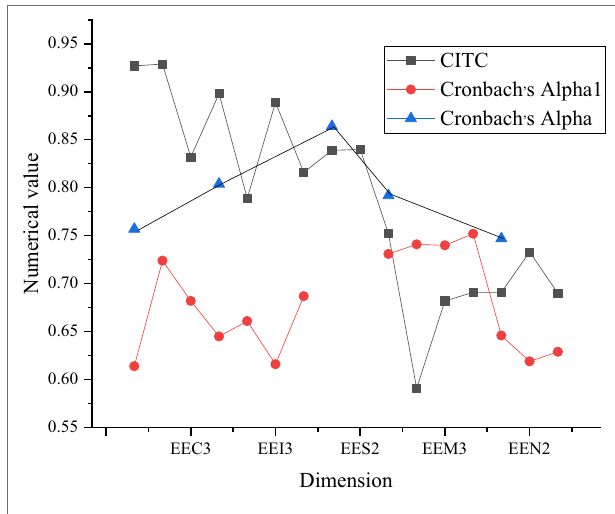
FIGURE 5 | Reliability analysis results of entrepreneurial performance scale (ESP2 represents two evaluation factors of survival performance in entrepreneurial performance, EPG2 represents the first two evaluation factors of growth performance dimension, and EPG4 represents four evaluation factors of growth performance dimension).